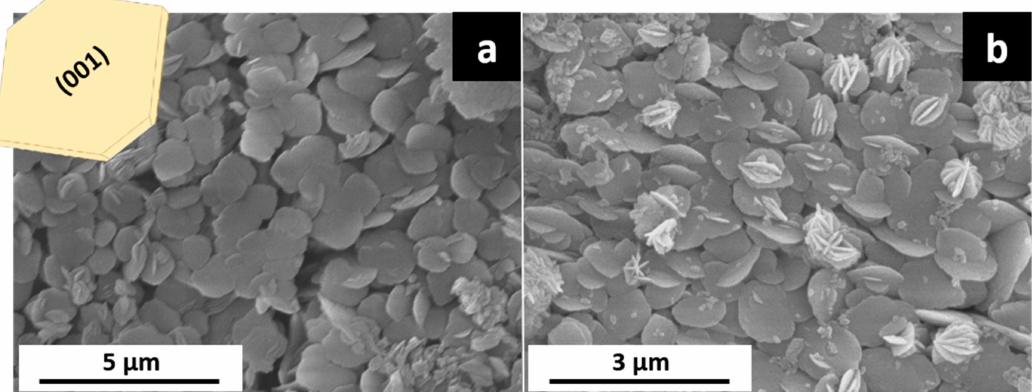
Figure 7. ( a ) SEM micrograph showing the formation of a micrometer-sized layer of barite that surrounds a gypsum crystal after 30 min interaction with a 0.5 M Ba-bearing aqueous solution. The habit of barite crystals is dominated by flat faces that belong to the {001} form and curved edges perpendicular to the [001] direction. These crystals grow with their (001) faces parallel to the gypsum (010) substrate and are nearly pure in composition according to EDX analyses. ( b ) As the interaction progresses barite appears as desert-rose-like crystals aggregates rather than as single